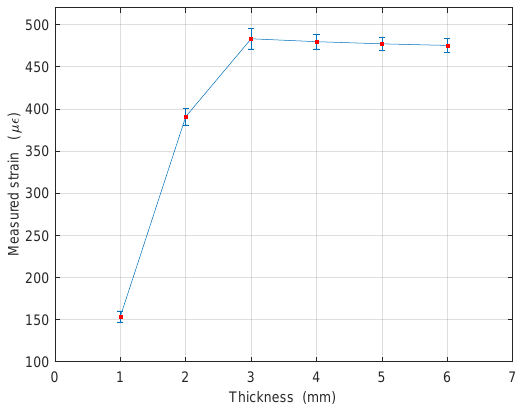
Figure 13. Average strain value acquired for each steel plate